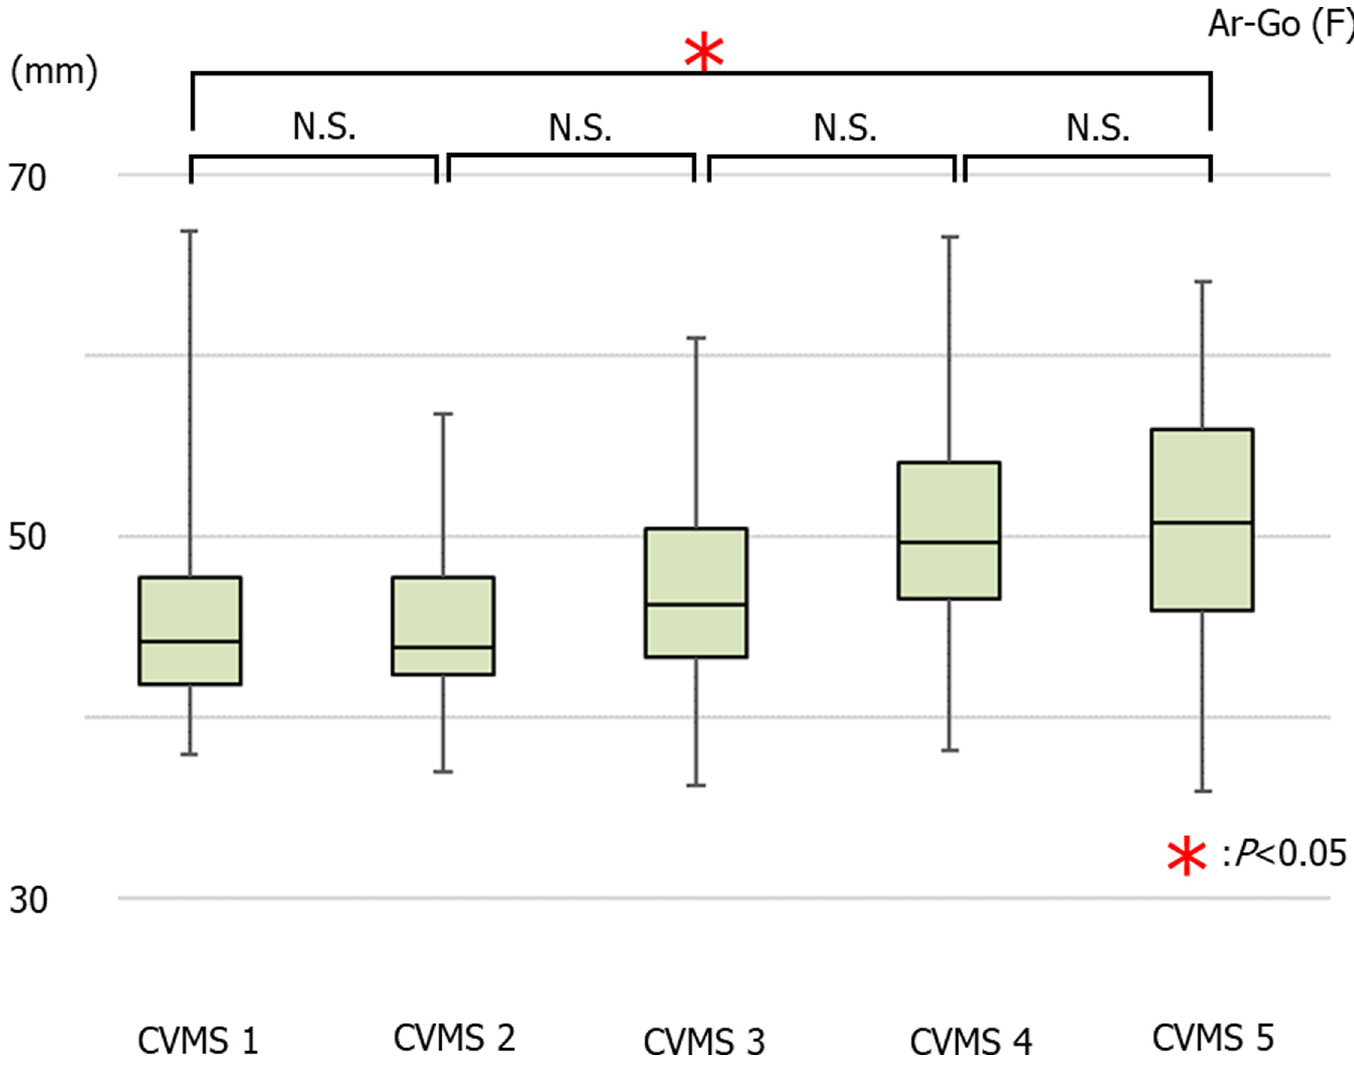
Fig 5. The average values of Ar-Go in females ( � p <